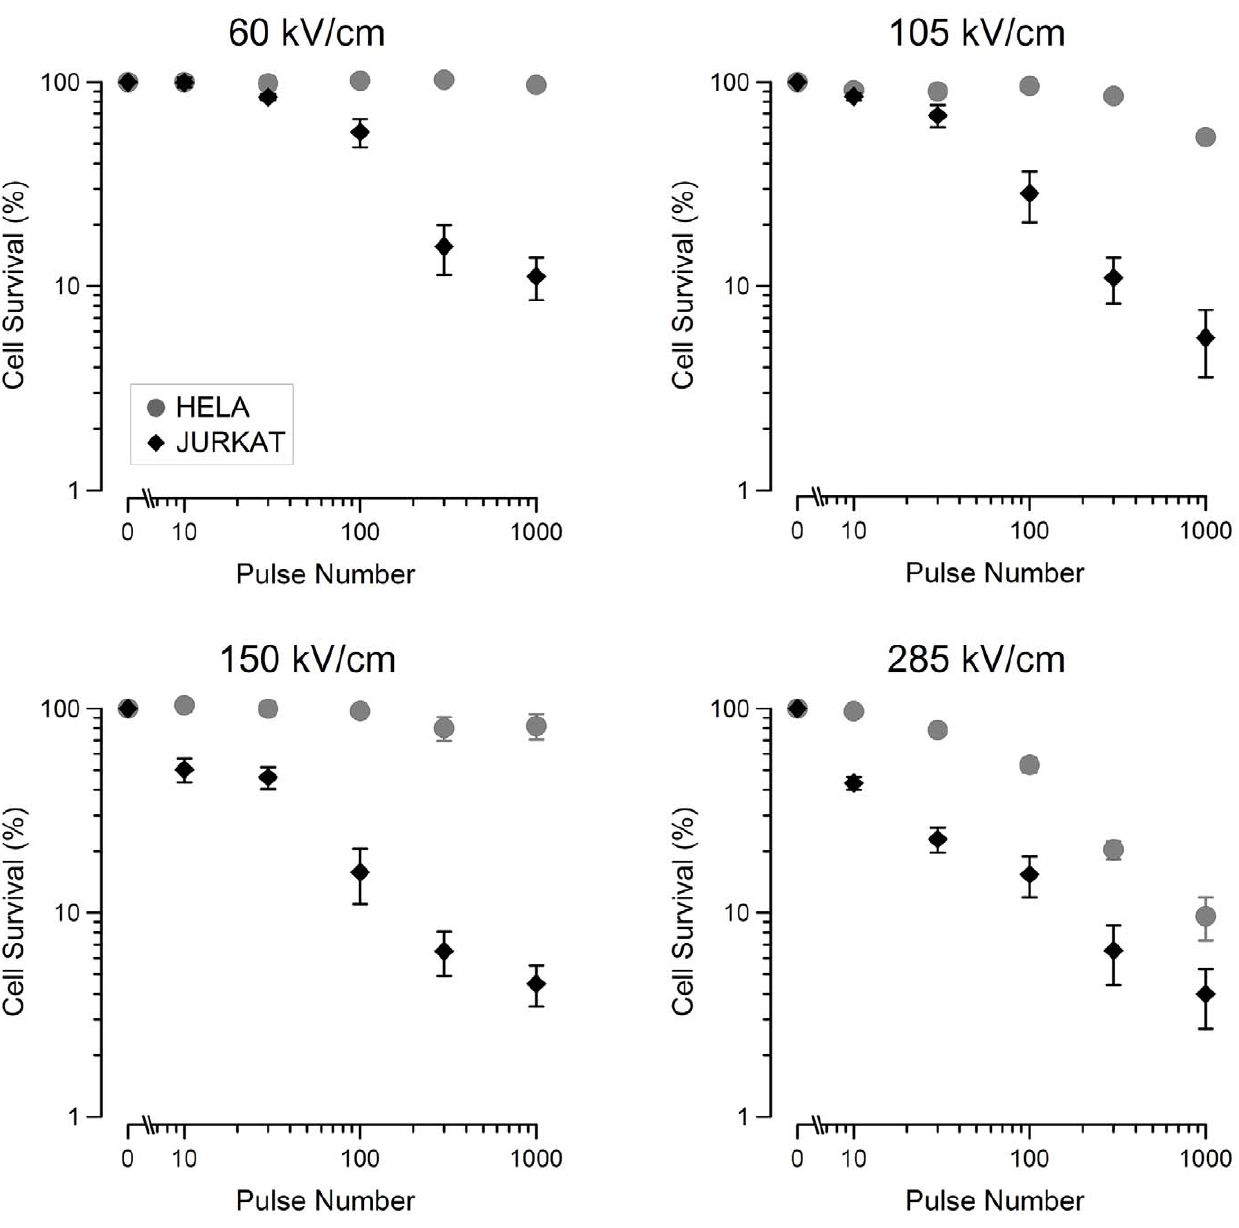
Figure 1. Jurkat and HeLa survival decreases with increasing electric field amplitude and pulse number. Cell survival curves for Jurkat and HeLa cells exposed to 60,105, 150, and285 kV/cm. Thedata shows that thenumberof cells that survive post-exposure decreases with increasingelectric field and pulse number. For all exposures, Jurkat cells are more sensitive than HeLa cells. Data points represent the average survival. (mean + / 2 s.e.,